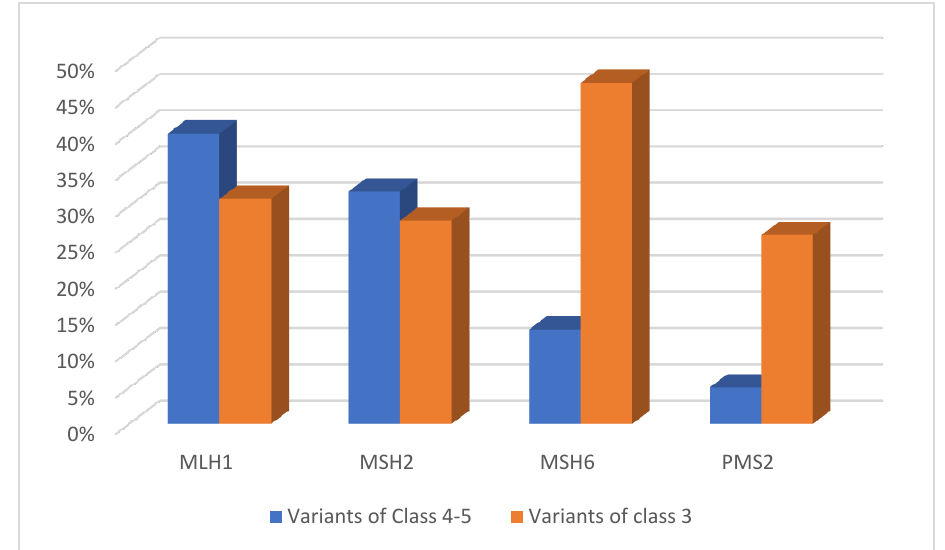
Figure 3 . Distribution of pathogenic and likely pathogenic variants and VUS in MMR repair genes.